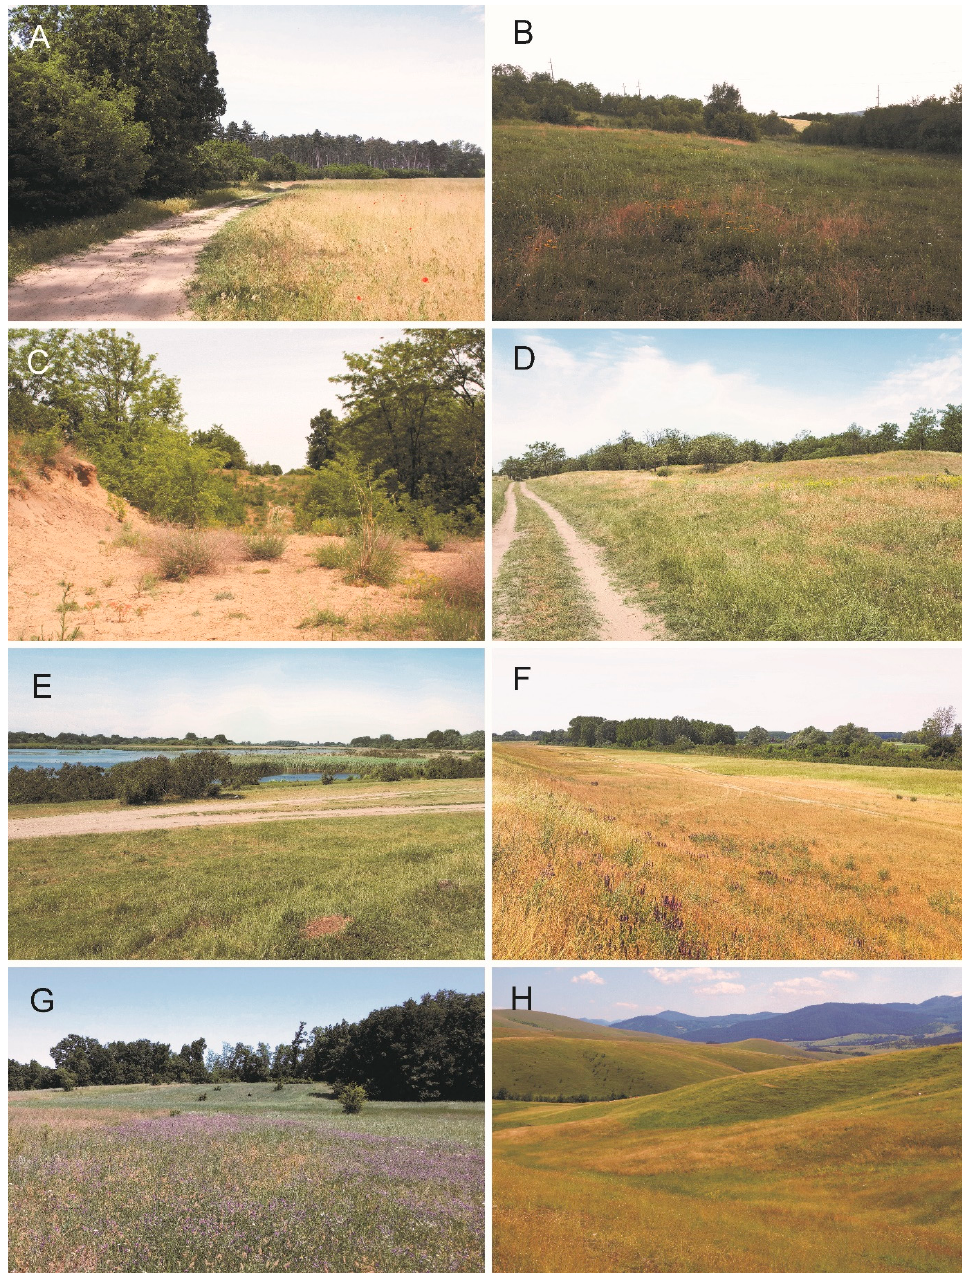
Figure 2. Collection localities of the scarabaeoid beetles in Serbia (2013, 2017–2019, 2021, 2022): ( A )— Figure Pali ć at Subotica, ( B )—Vrdnik at Irig, ( C )—Šušara at Vršac, ( D )—Deliblato at Kovin, ( E )—Dubovac at Kovin, ( F )—Malo Bavanište at Kovin, ( G )—Mala Jasikova at Zaje č ar, ( H )—Jablanica at Č ajetina (Photos: ( A , C , G )—Tomasz Gazurek, ( B , D , E )—Adam Byk, ( F )—Sebastian Tylkowski and ( H )— Dawid Marczak).